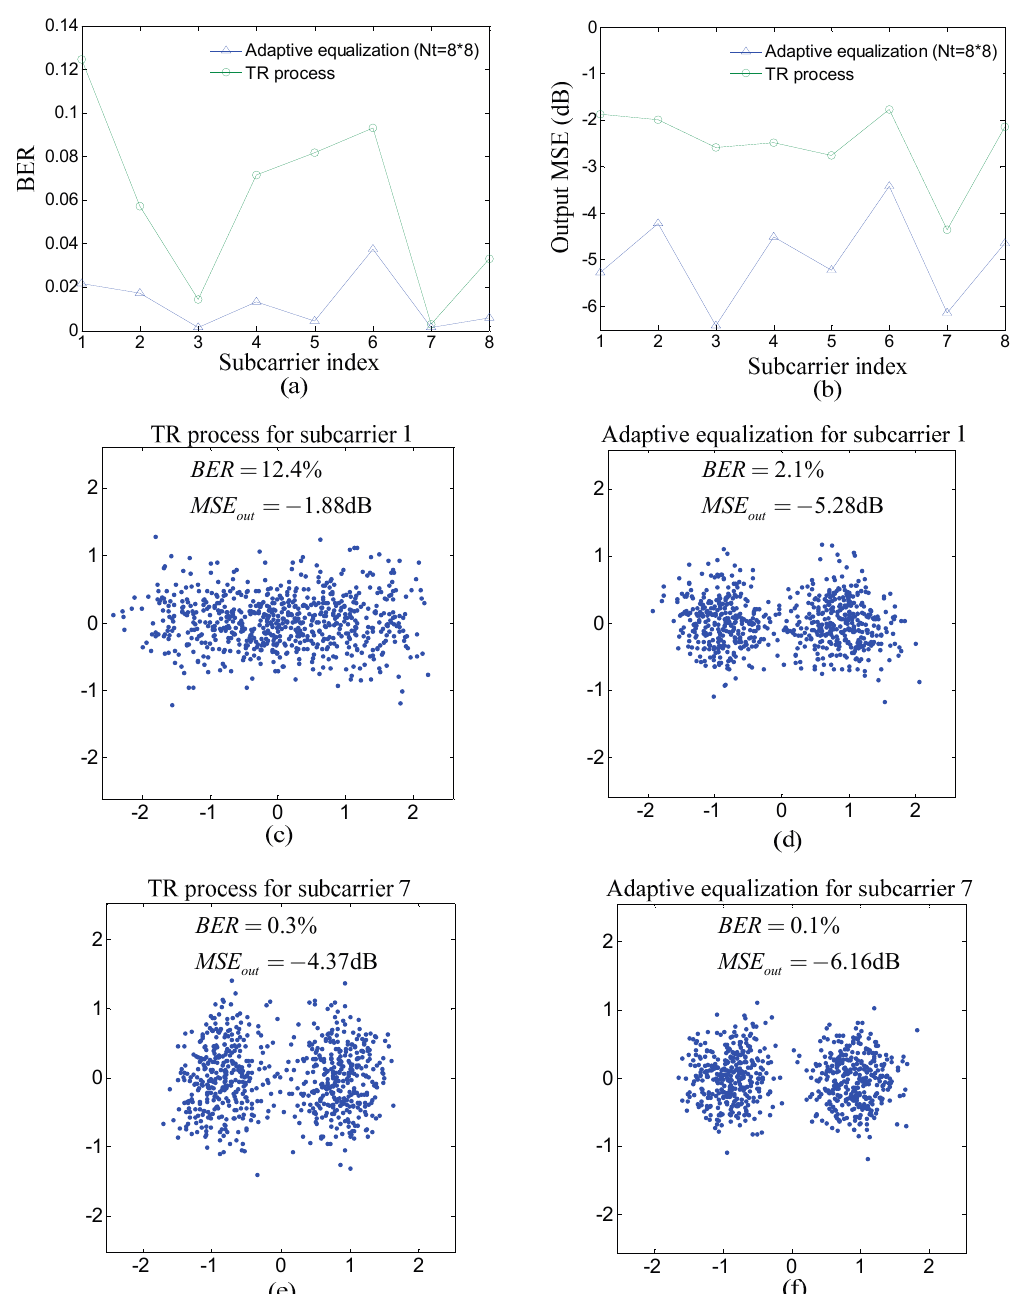
Figure 9. Experiment results for each subcarrier of the proposed method: ( a ) BER of the TR process and adaptive equalization; ( b ) output MSE of the TR process and adaptive equalization; ( c , d ) scatterplots of the TR process and adaptive equalization for subcarrier one; and ( e , f ) scatterplots of the TR process and adaptive equalization for subcarrier